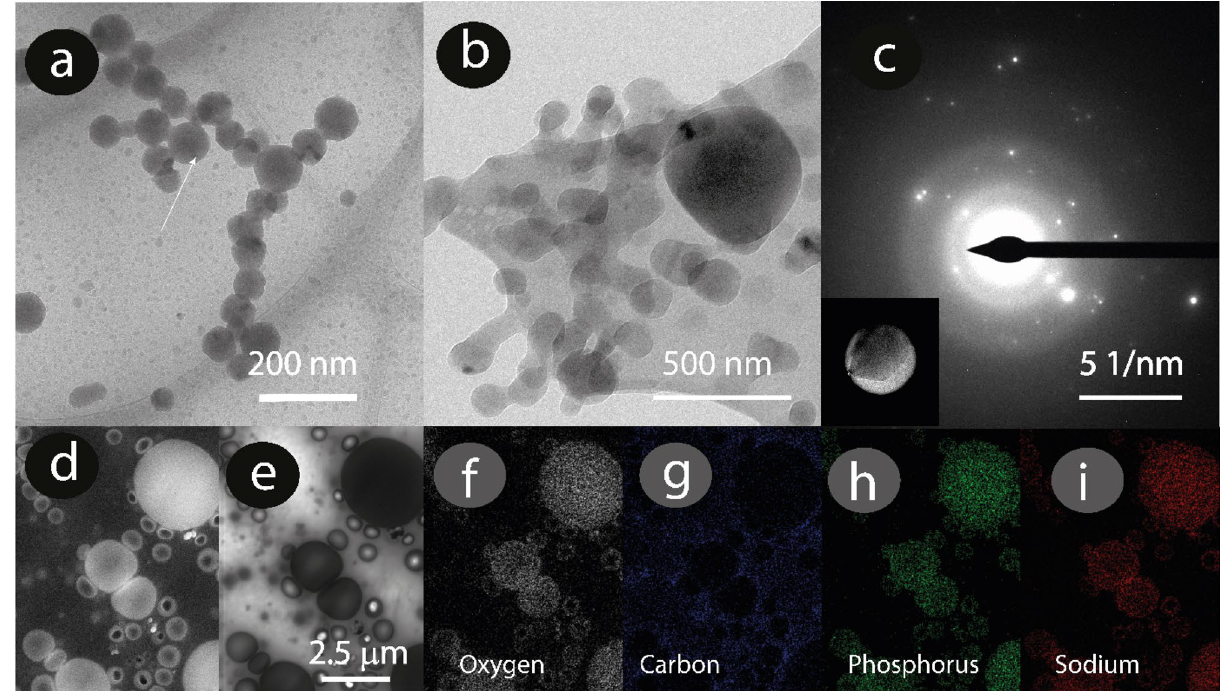
area electron diffraction (SAED) analysis of an electron-dense particle in the expelled slime. ( d-i ) STEM micrographs. ( d ) HAADF detector. ( e ) Bright-field detector. ( f-i ) Oxygen, carbon, phosphorus and